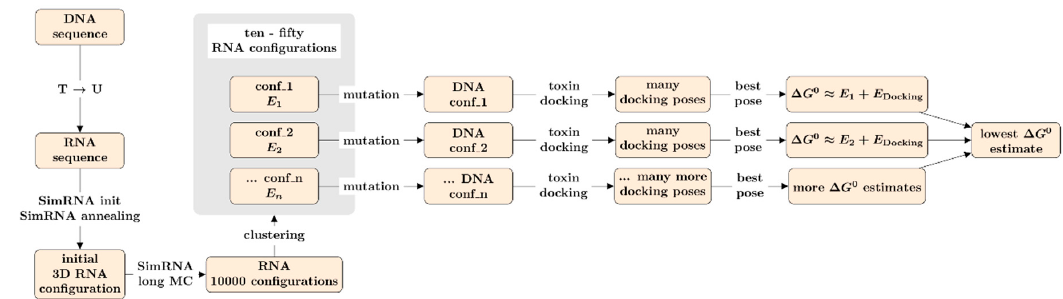
Figure 1. Scheme of the computational pipeline bringing from aptamer sequence to affinity estimate.